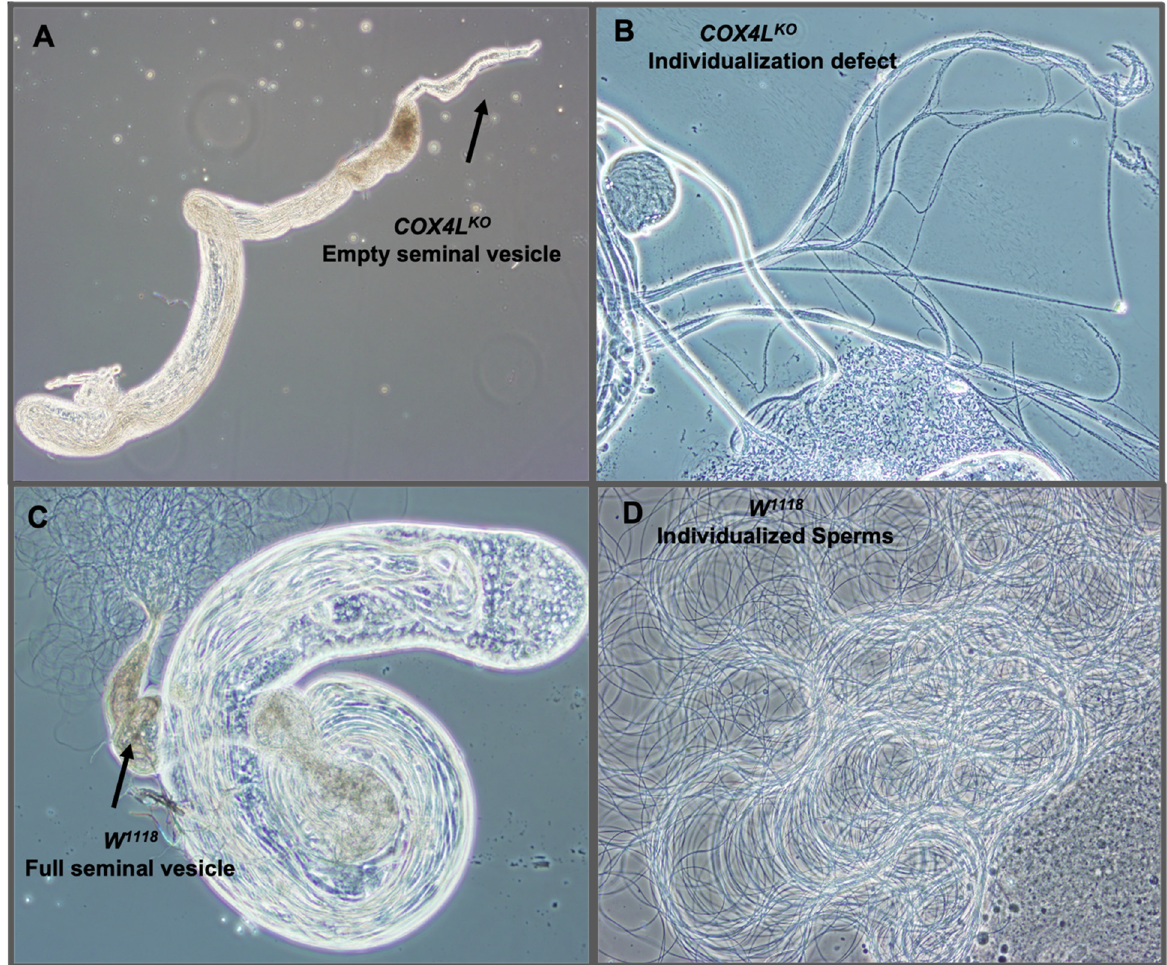
Figure 3. Dissected testes of COX4L -KO: ( A ) Dissected testes of COX4L -KO with an empty seminal vesicle are shown. ( B ) Sperm bundle with individualization defect. ( C ) w 1118 control testis with normal spermatogenesis stages and a full seminal vesicle. Additionally, mature sperms are shown moving around the raptured seminal vesicle. ( D ) Wild-type mobile individualized